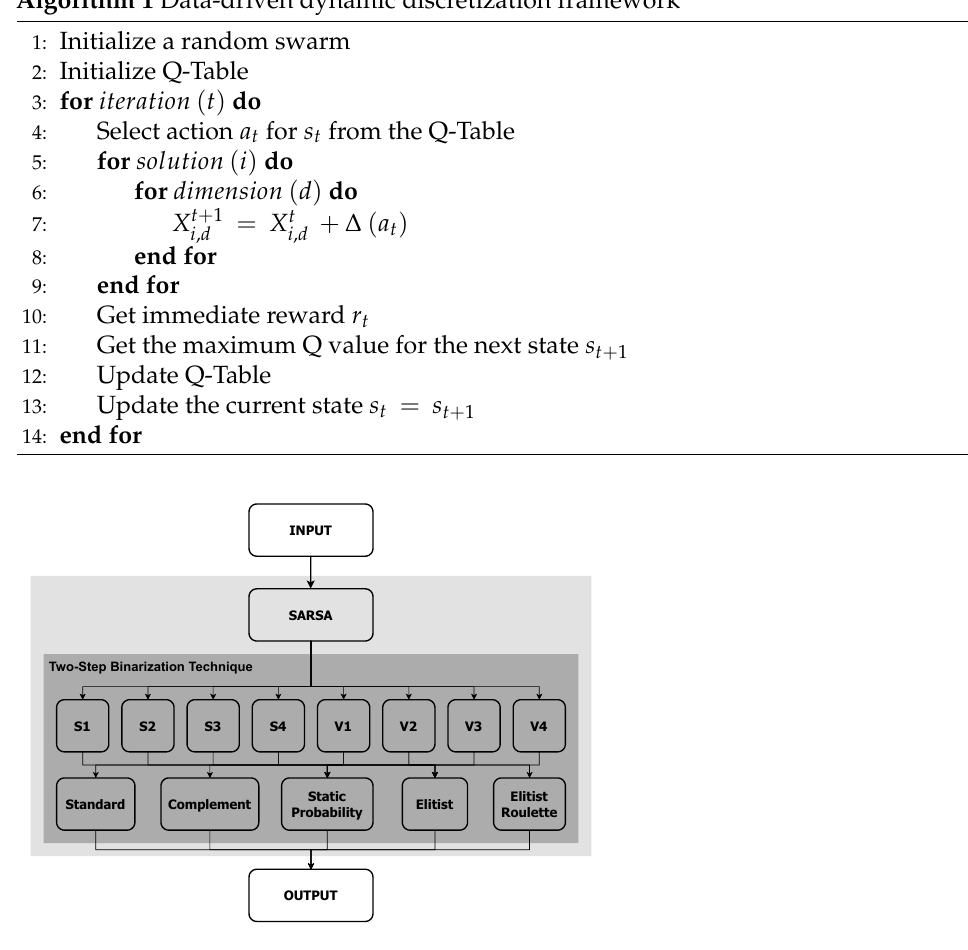
Figure 3. Binary scheme selector with SARSA as a smart